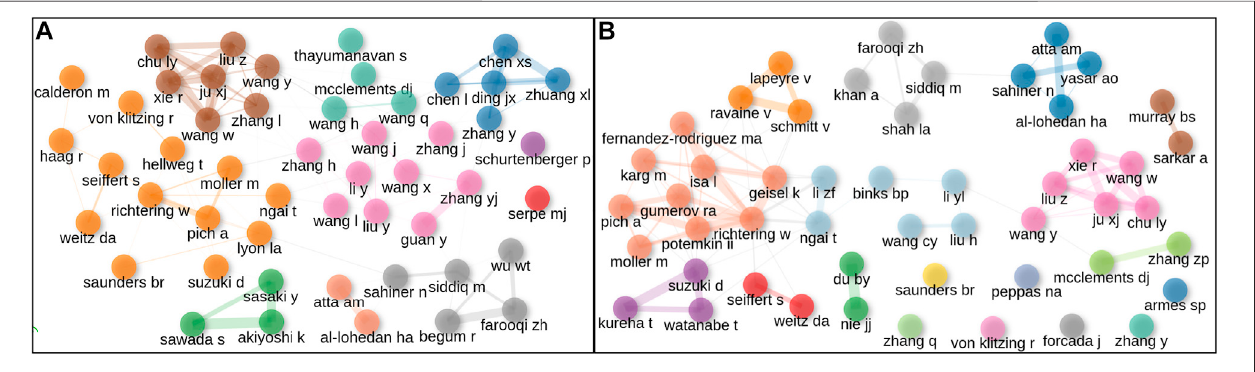
FIGURE5| Socialstructure ofthemaintopicandsub-topic.Collaborationnetworkconstructedfromoccurrenceofco-authorshipbetweentheyears2010 – 2020, showing the 50 most frequent co-authorship for (A) the main topic “ microgels and nanogels ” and (B) the sub-topic “ microgels and nanogels at interfaces and emulsions ” . Clusters ofco-authors areidenti fi edwith thesame color and thethicknessofthelinks correspond tothestrength ofthe co-authorship.The isolated authors are an artifact of plotting 50 authors for the sake of clarity. Plots are produced with Biblioshiny.